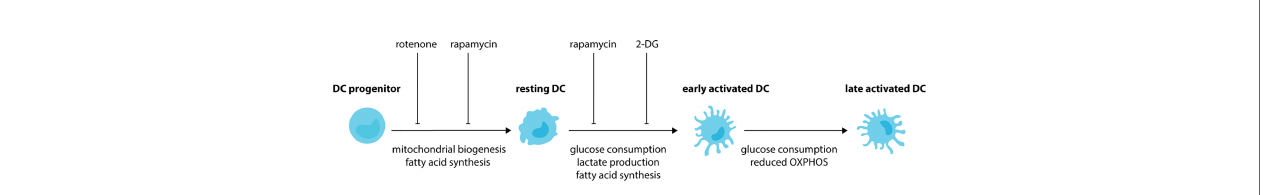
FIGURE 2 | DCs undergo metabolic rewiring during development and activation. During the development of DCs, progenitor cells increase mitochondrial biogenesis and fatty-acid synthesis. These metabolic changes lead to DCs with an increased mitochondrial metabolism in comparison to their progenitors. Treatment of progenitor cells with rotenone (respiratory chain inhibitor), TOFA (acetyl CoA carboxylase inhibitor) and rapamycin (mTORC1 inhibitor) impairs the development of DCs. Upon exposure to activating stimuli, resting DCs rapidly increase consumption of glucose and their production of lactate and fatty acids. As a result, impaired activation is observed when DCs are treated with glycolysis inhibitor 2-DG, fatty-acid synthase inhibitor C75 or TOFA. Glycolysis is maintained during the later stages of DC activation, however, a reduction in OXPHOS also occurs.